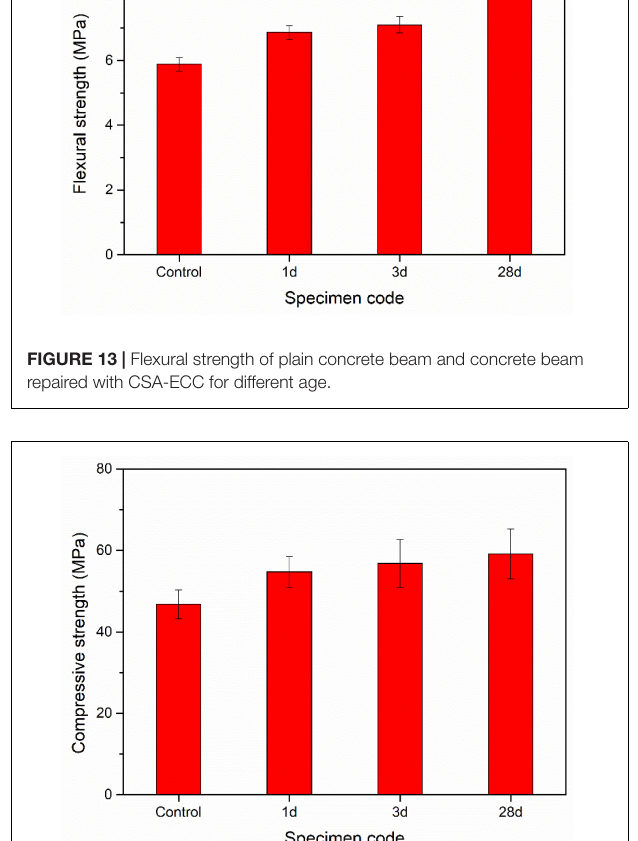
Frontiers in Materials |